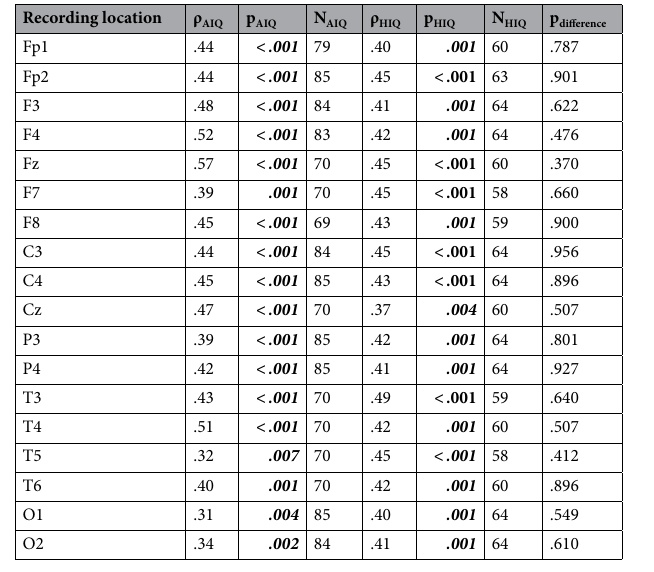
Table 2. Comparison of the correlations between age and the slope of the NREM sleep EEG spectra in subjects with average and high intelligence (AIQ vs HIQ). Spearman rank correlations (ρ) were significant in both intelligence groups, however, the differences between the higher (HIQ) and average (AIQ) intelligence groups was not significant (p difference ). Bold italic values indicate statistical significance at p <